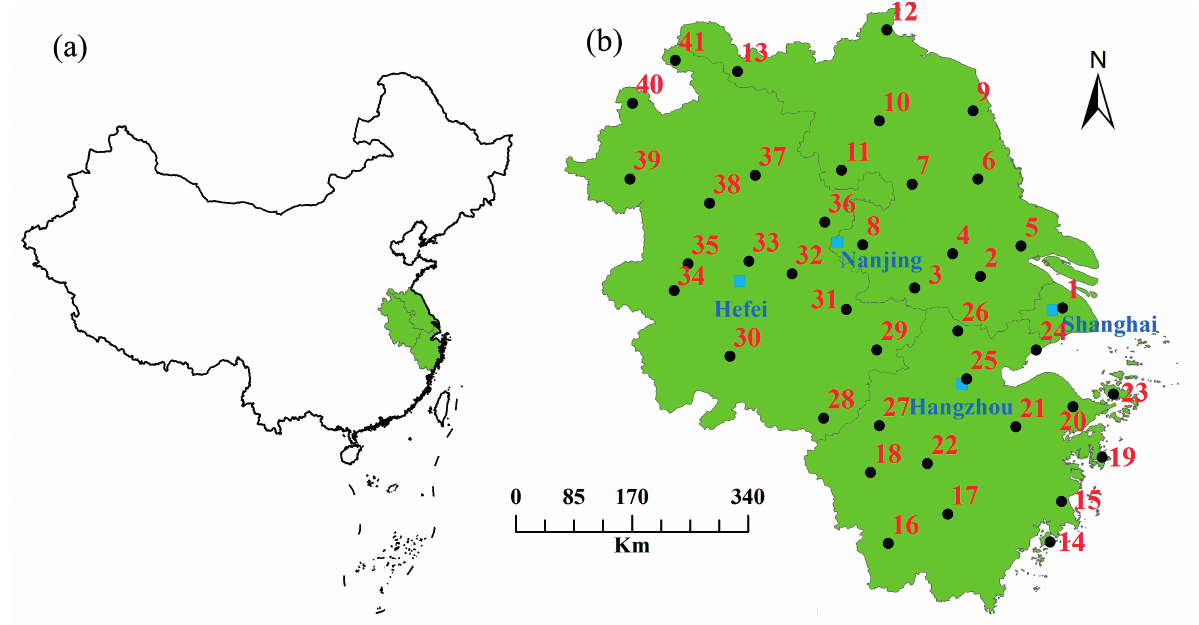
Figure 1. Locations of the YRDUA ( a ) and the 41 meteorological stations ( b ). 1: